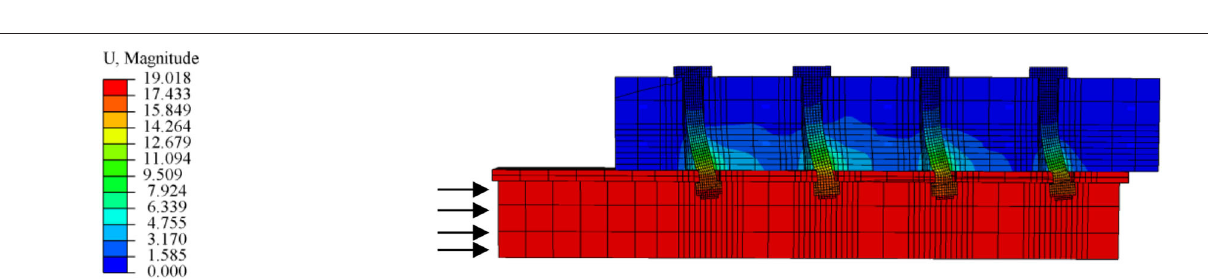
FIGURE 9 | Effect of bolt row numbers: (A) load–slip relationship; (B) shear-bearing capacity; and (C) shear stiffness.